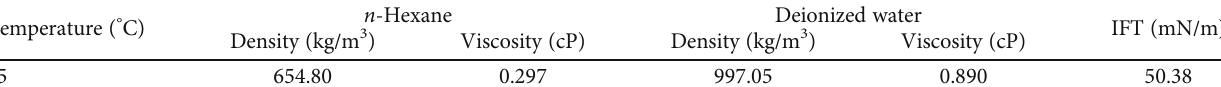
Table 1: Fluid properties and interfacial tension of hexane and water at ambient pressure.